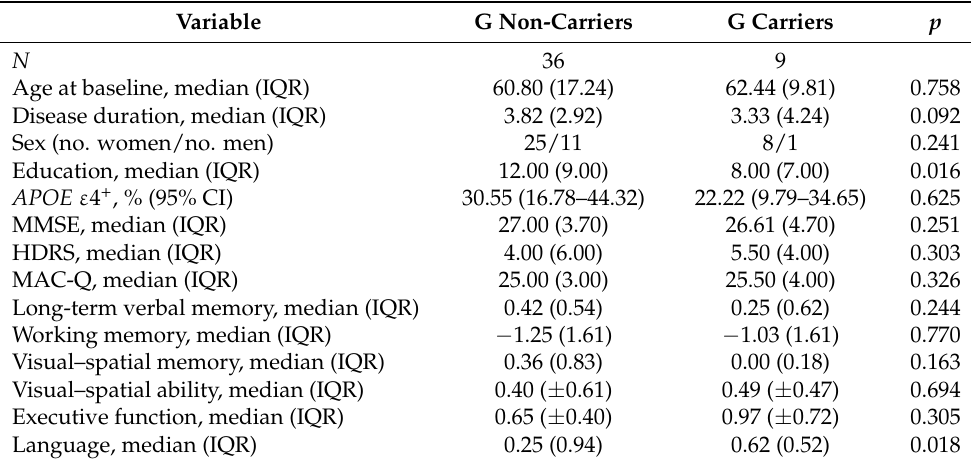
Table 1. Comparison of demographic, cognitive, and genetic features between G carriers and G non-carriers. G Non-Carriers G